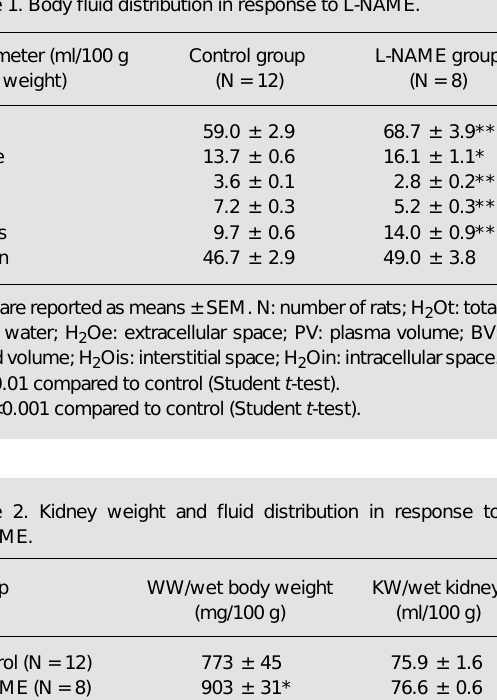
Table 1. Body fluid distribution in response to L-NAME.